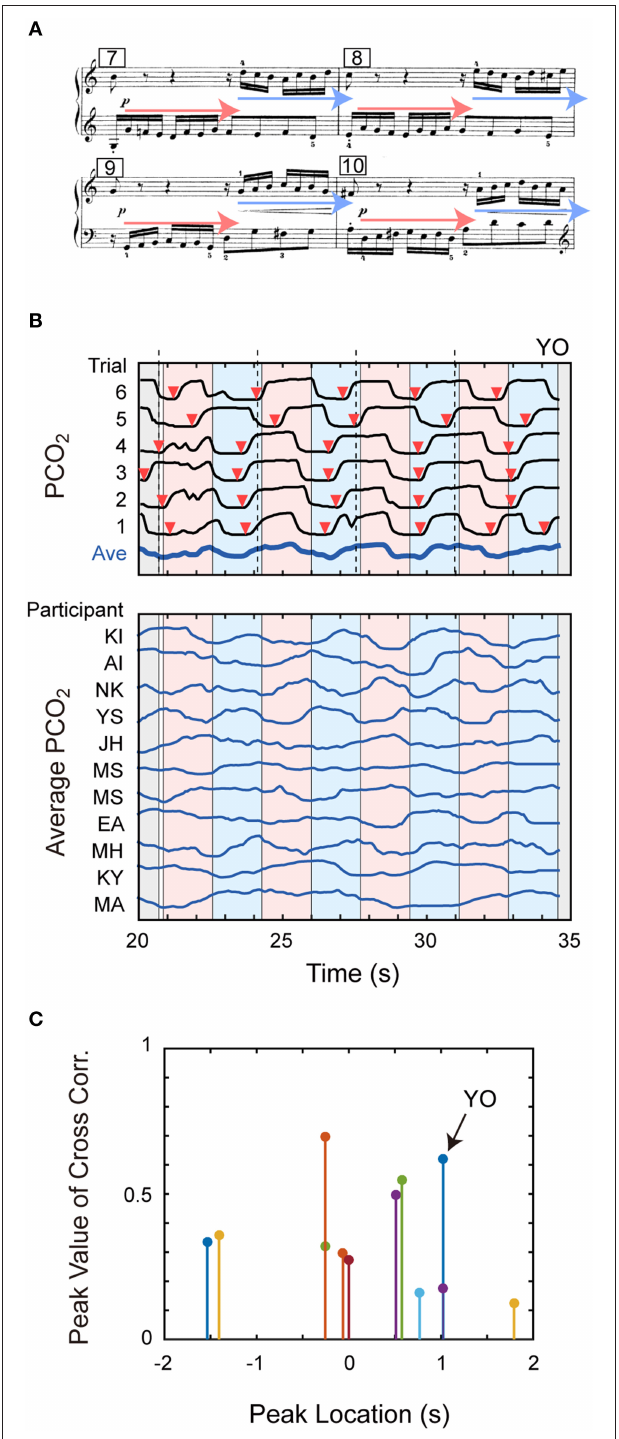
FIGURE 7 | Breath patterns for an excerpt having two voices. (A) The score of the final part of Excerpt D is shown. As indicated by the reddish and bluish arrows, pairwise subjects are played four times in this part. (B) Top panel shows temporal patterns of PCO 2 of individual trials and its average pattern for one participant. Bottom panel shows the average PCO 2 patterns of